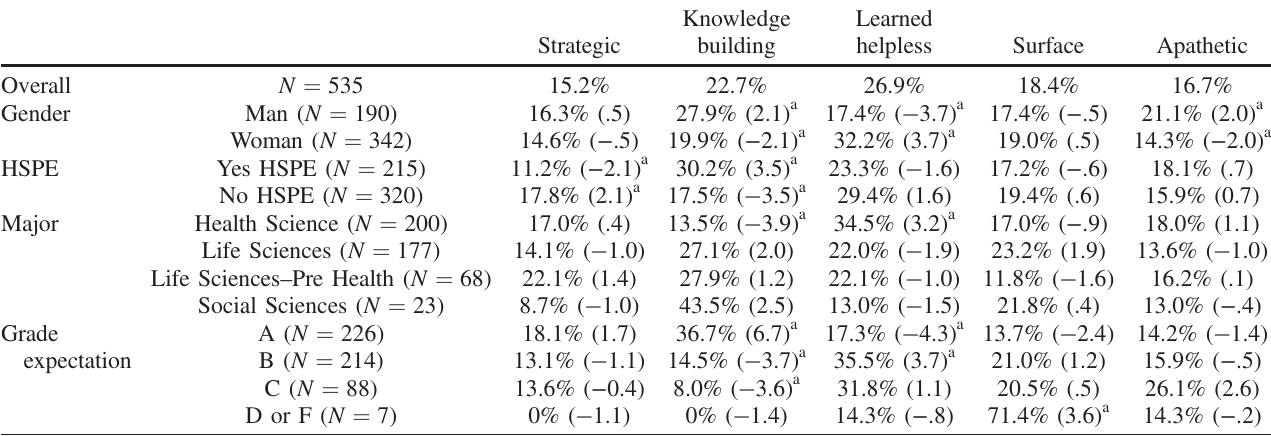
TABLE VIII. Contingency tables for demographic variables with significant interactions with learning profile. Row percentages and adjusted residuals (in parentheses) given in each